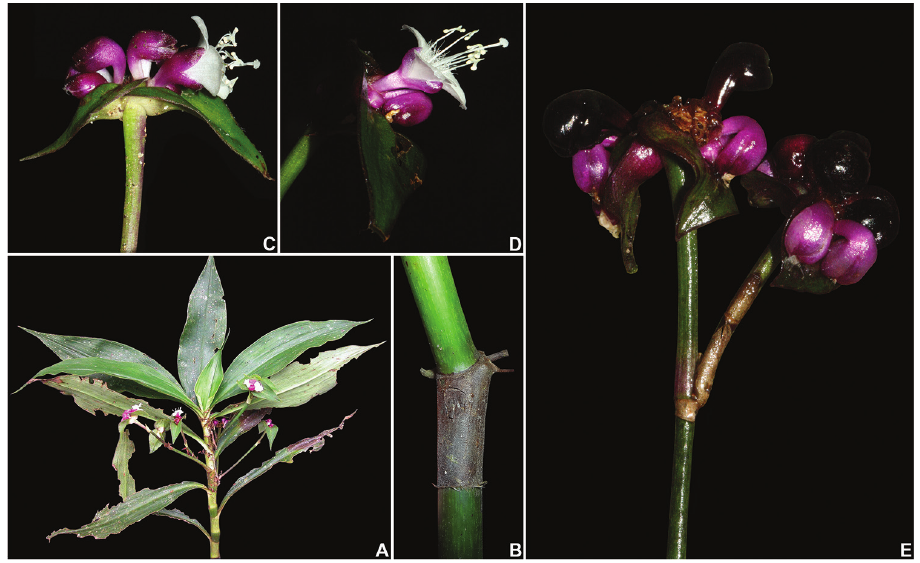
Figure 4. Tradescantia zanonia (L.) Sw. A habit, showing the axillary inflorescences perforating the leaf- sheaths B detail of the leaf-sheath C detail of the inflorescence, showing the spathaceous, saccate cincinni bracts, geniculate flowers, and basally conate sepals D side view of a flower, showing the shallowly-tubular flower, subequal stamens, sagittate connectives, round anther sacs, and trilobate stigma E detail of a branched synflorescence, bearing berry-like fruits. Photograph A by A.P. Maceda, B by P. Schwirkowski, C–E by M.O.O.